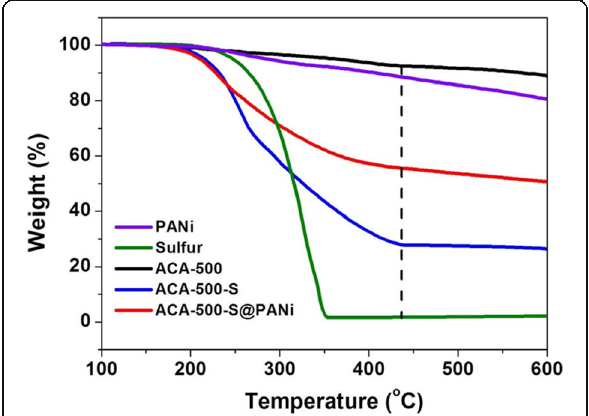
Fig. 4 TGA curves of PANi, pure sulfur, ACA-500, ACA-500-S, and ACA-500-S@PANi